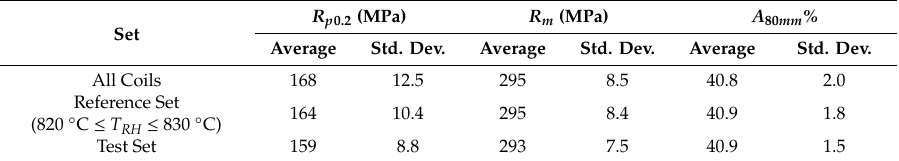
Table 5. Results of the o ffl ine tests for Steel Code A and thickness range 2 (0.7–0.9 mm). Set